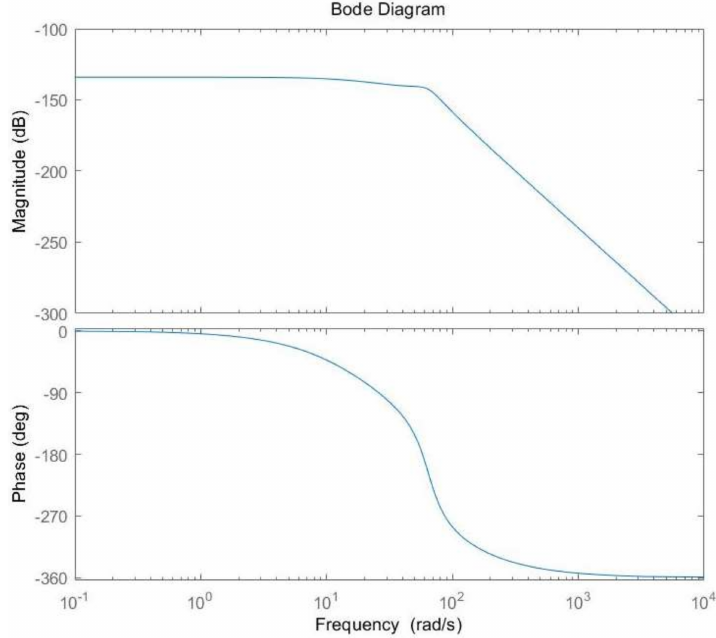
Figure 14. The Bode diagram of the